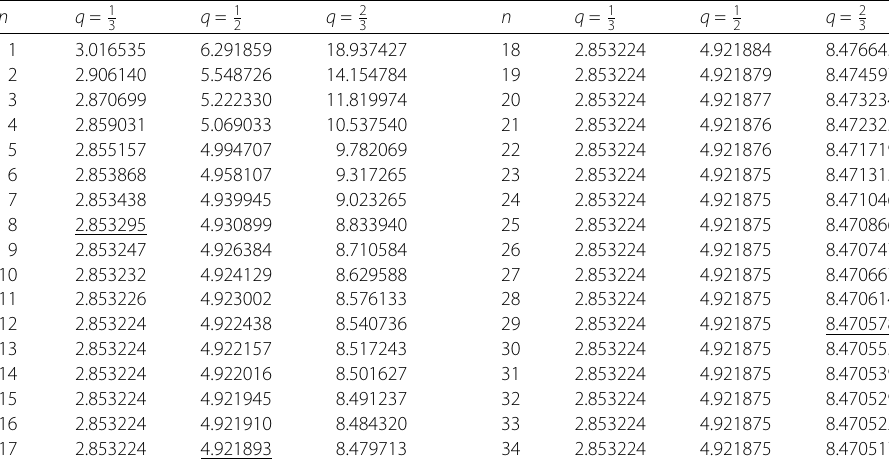
, 1 , 2 , x = 5 and n = 1,2, ... ,35 of 3 2 3